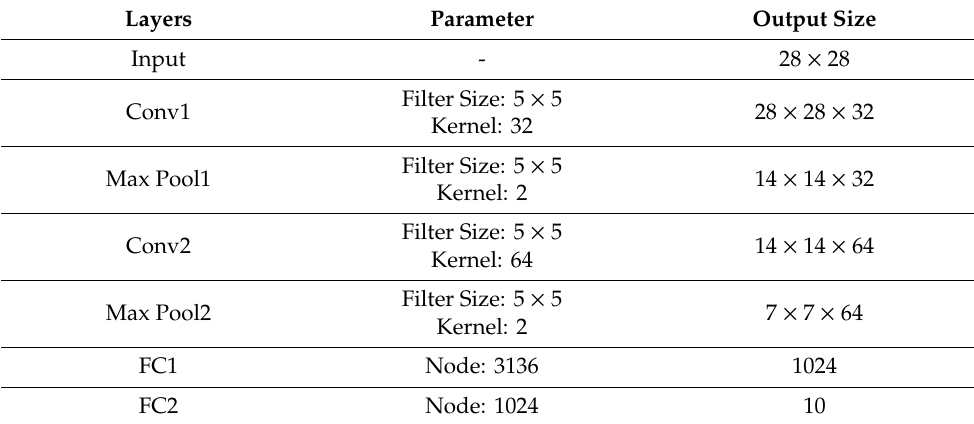
Table 1. Details of extended CNN